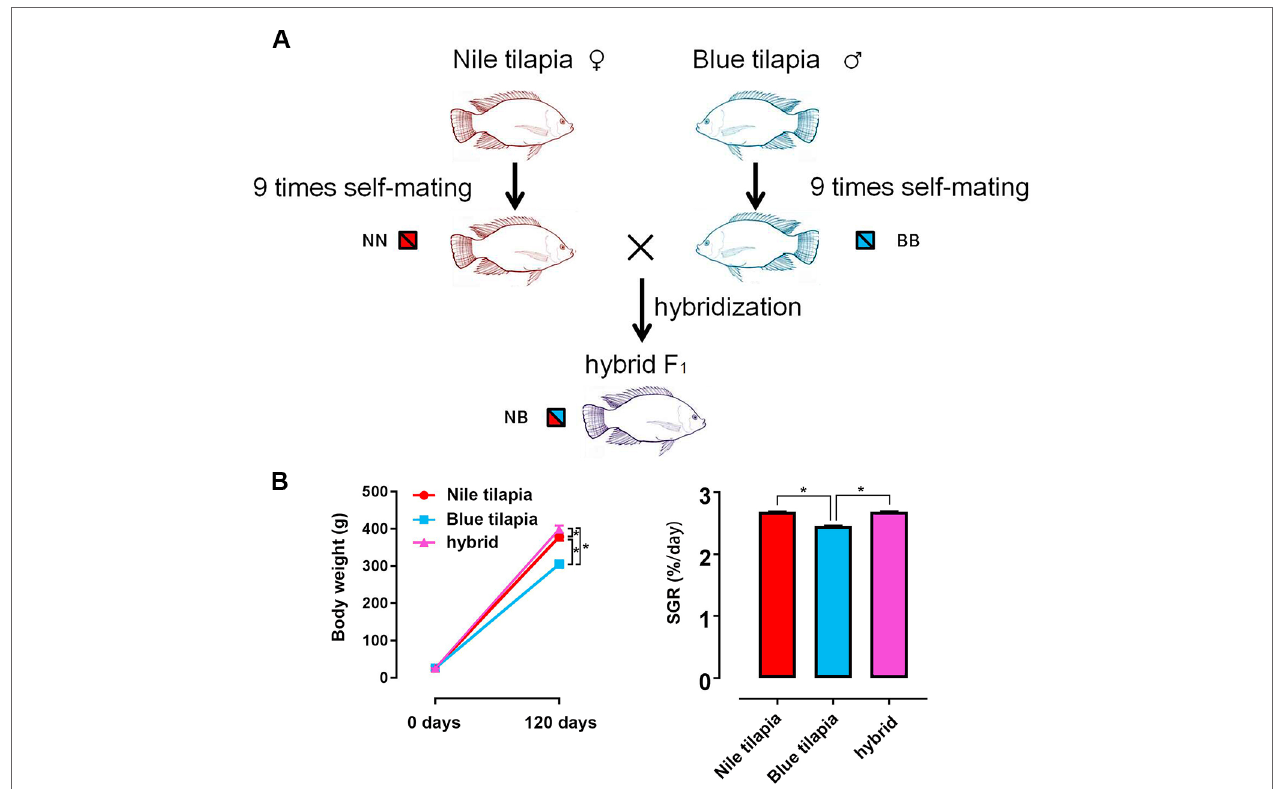
FIGURE 1 | Generation of hybrid tilapia and growth performance. (A) The parents of the hybrid (Nile tilapia and blue tilapia) were obtained nine times after self- mating to guarantee a pure genetic background. Then, hybrid tilapia was obtained by Nile tilapia and blue tilapia crossing. The genotypes of Nile tilapia, blue tilapia, and hybrid were represented as NN, BB and NB, respectively. (B) Body weight and SGR comparison among Nile tilapia, blue tilapia, and hybrid. Data are presented as the mean ± SEM (n = 20). Asterisks indicate significant differences between groups ( P <